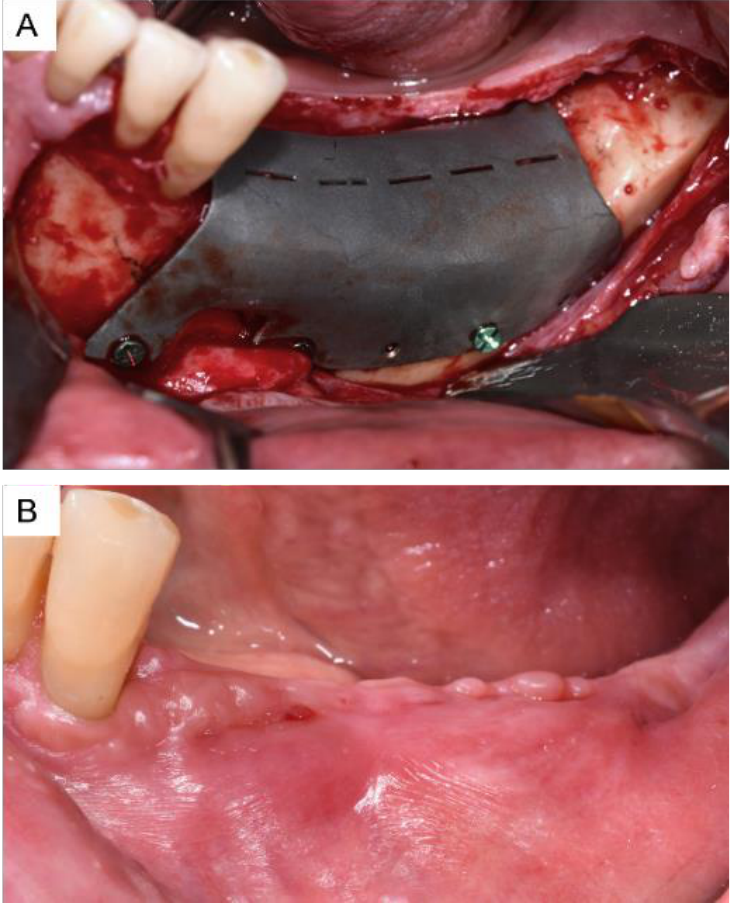
Figure 6. The intra-operatory vision of the fixed membrane ( A ) and clinical situation a month after surgery ( B ) relative to the first case.